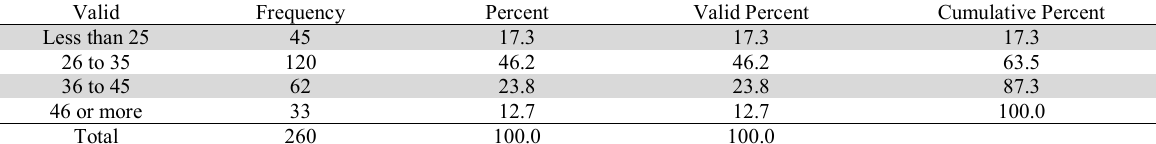
Descriptive statistics of Age of Participants